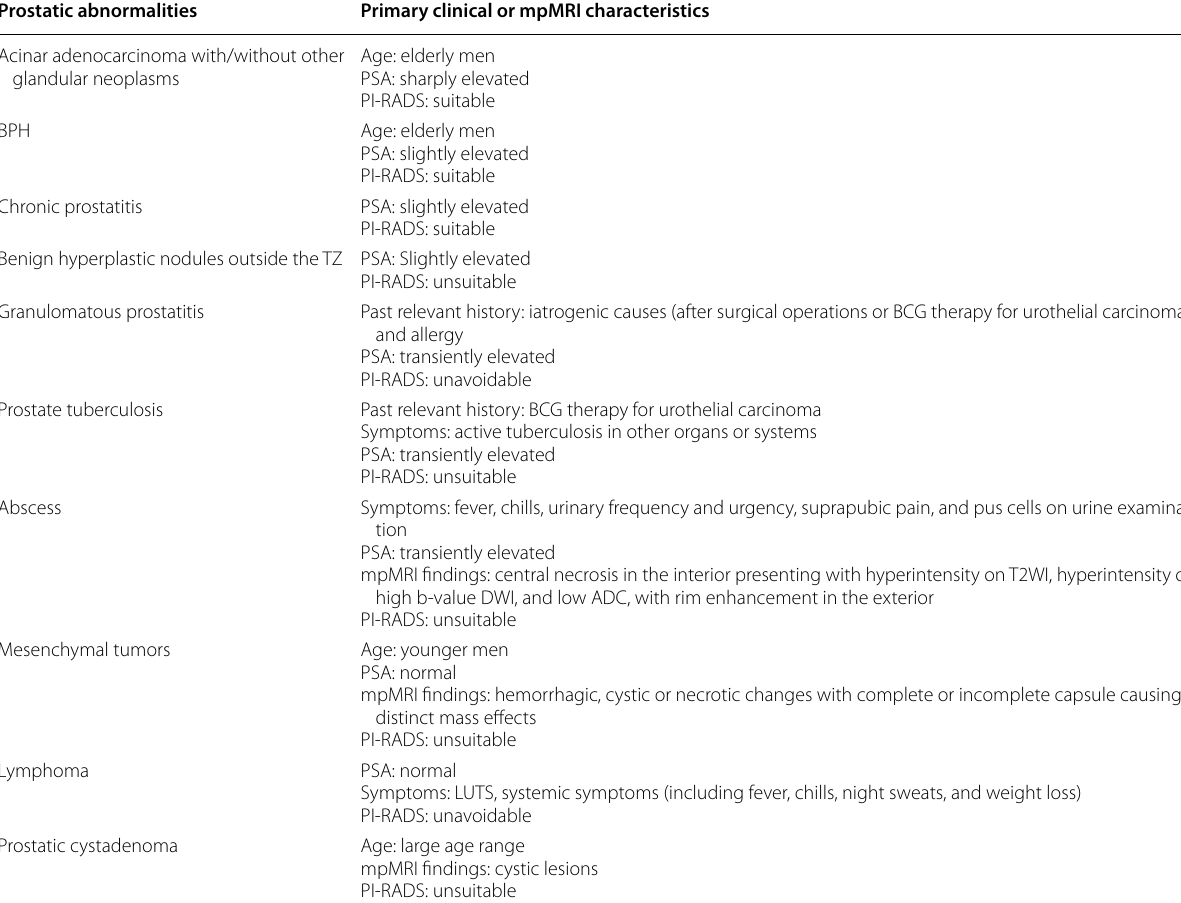
lower urinary tract symptoms